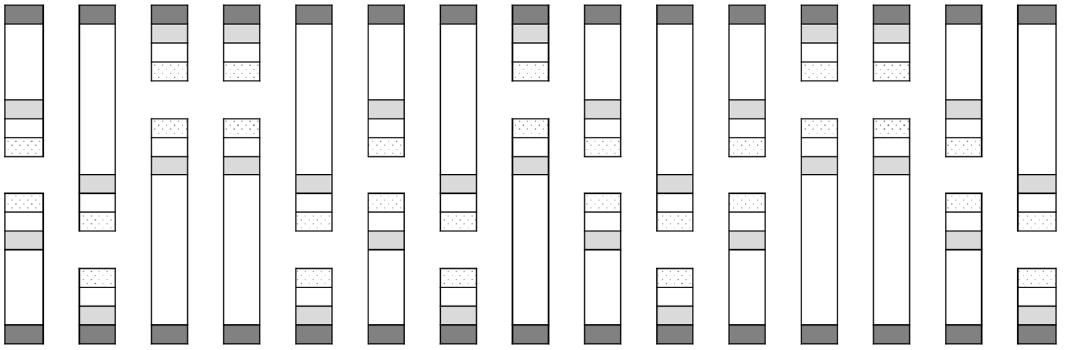
Figure 2. Layout of field cages for Cage Study 2. The areas shaded in dark grey represent turnip rape border plants placed at cage openings. The areas shaded in light grey represent cauliflower plants inside cages at varying distances from the turnip rape plants. The un-shaded checkered areas at the very end of the cages indicate the location of water traps.